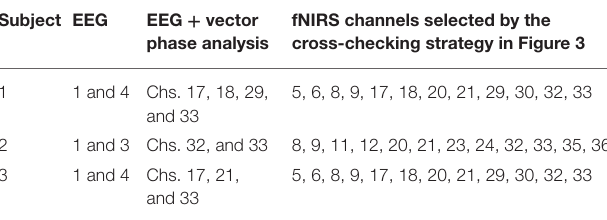
TABLE 1 | Selected EEG and fNIRS channels per